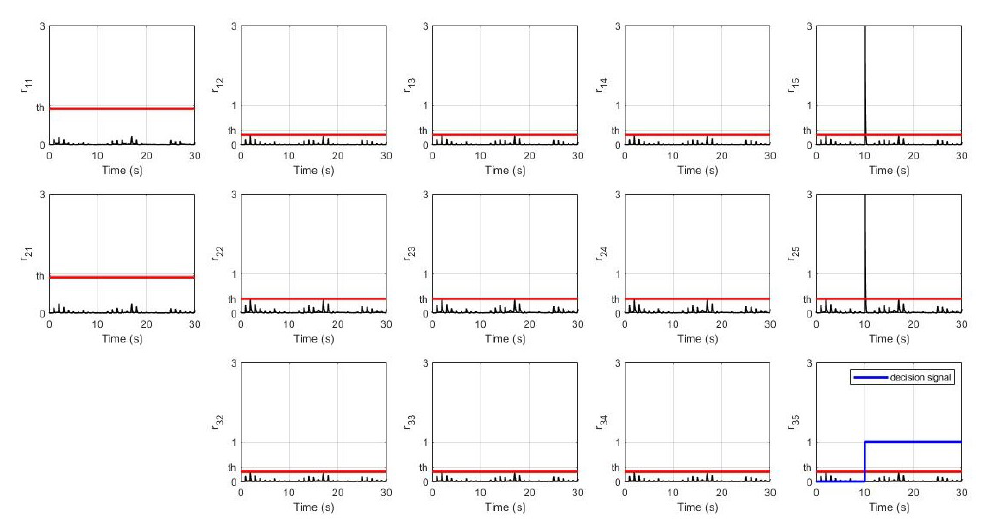
Figure 12. Residual signals with sensor S3 fault in the 5th